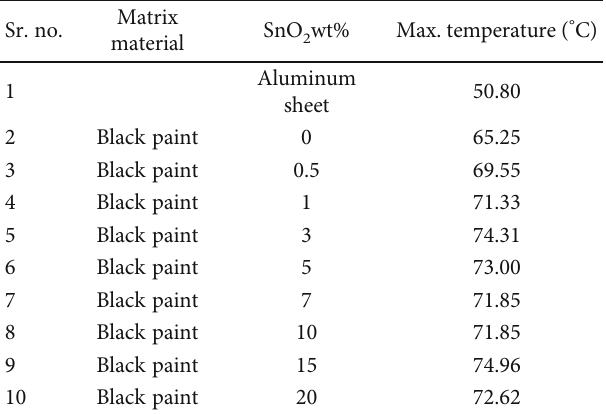
Table 3: Summary of outdoor experimental results. Sr.